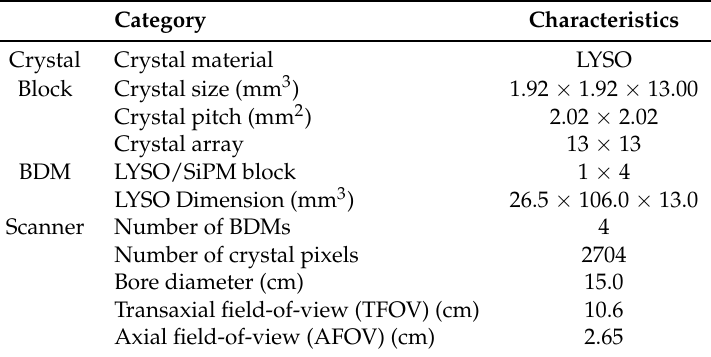
Figure 3. Our small-animal PET scanner employs 4 BDMs. Table 2. The general specifications of the LIGHTENING (cid:114)